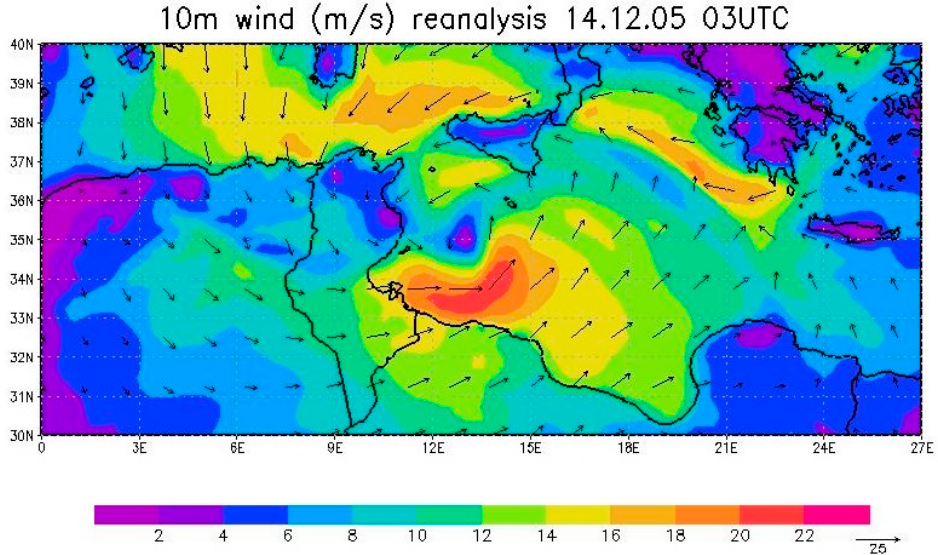
Figure 5. 10 m wind on 14 December 2005 03:00 UTC during the peak of the storm [16]. Wind speed contours in m s − 1 .